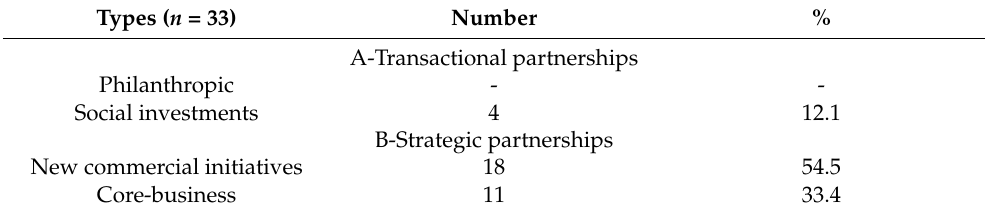
Table 10. Types of the partnerships.